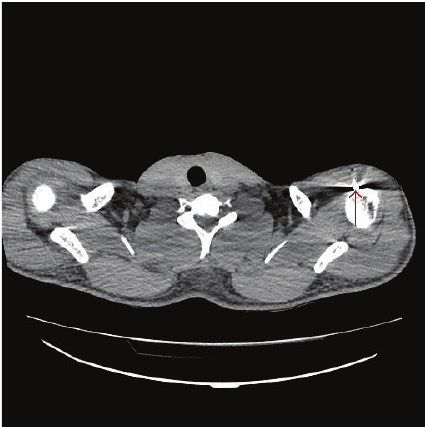
Figure 2: Transverse cut view of chest CT shows a bullet in the pericardial sac with pericardial effusion.